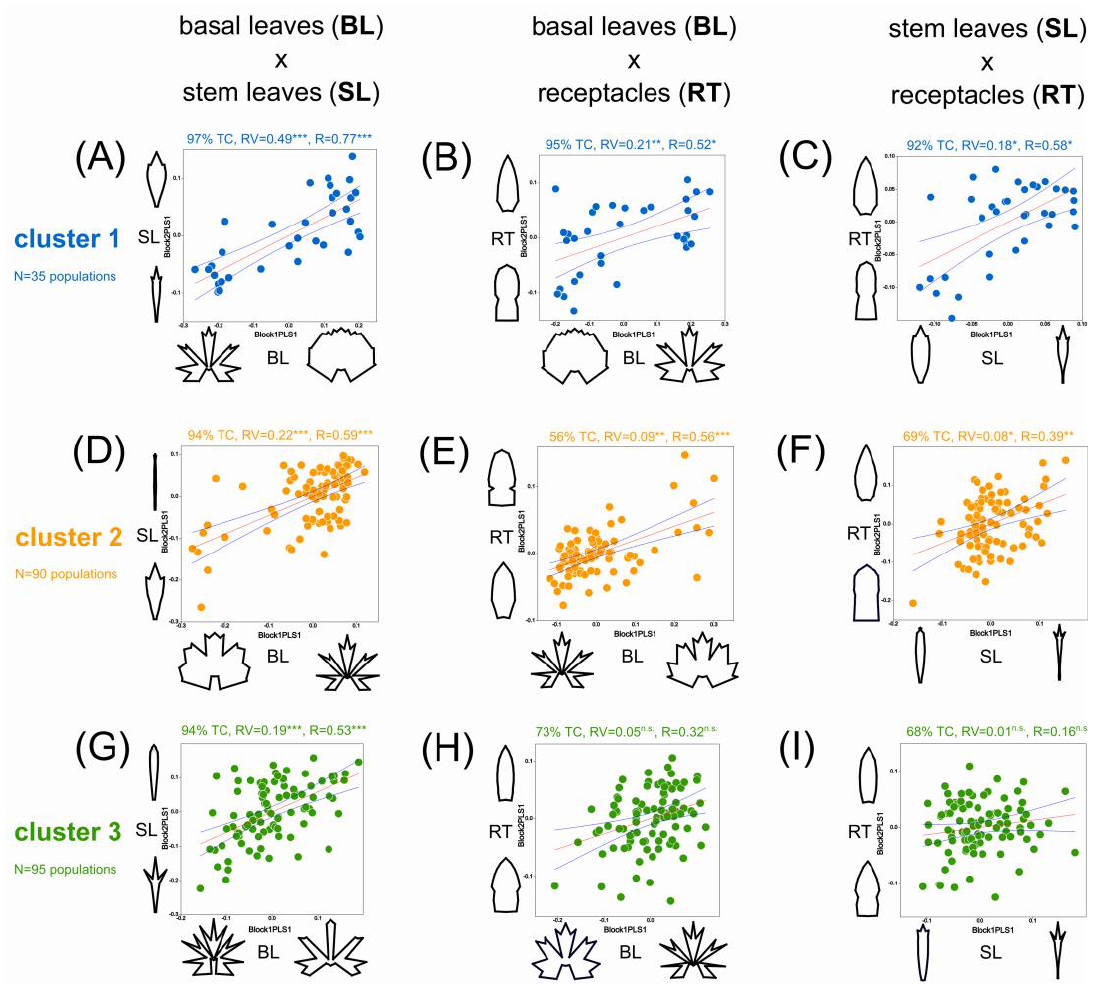
Figure 5. Covariation of the three taxonomically most informative traits is inferred for each RAD-Seq (RADpainter) cluster. The three morphological traits are plotted against each other in partial least-squares regression analyses of trait covariation. Within cluster 1 (inferred by RADpainter), the basal leaves are plotted against the stem leaves ( A ), against the receptacles ( B ), and the stem leaves against the receptacles ( C ). The same pairs of morphological traits were compared within clusters 2 ( D – F ) and 3 ( G – I ). Numbers above each plot give the amount of morphological covariation described by the first PLS axis (Block1PLS1 and Block2PLS1) as percentages of the total covariation (TC), a model fit statistic (RV) with its significance, and the correlation (R) of both PLS1 axes (each one representing one morphological trend). The coloring of sexual progenitors and clusters follows Figure 2 and [51], abbreviations as in Figures 3 and 4. R = correlation coefficient of PLS axes; RV = global correlation coefficient (multivariate analog of the squared correlation); * = p < 0.05; ** = p < 0.01; *** = p < 0.001; TC = total